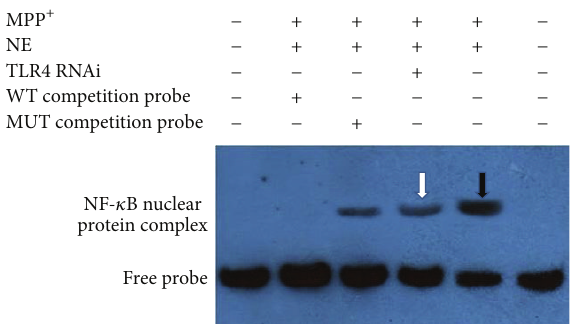
Figure 8: The effect of TLR4 RNA interference on NF- 𝜅 B activation in BV-2 cells exposed to MPP + for 12h (negative control group; WT cold probe group; MUT cold probe group; RNAi group; non-RNAi group; negative control group). Note that, in the group treated with TLR4 RNA interference, NF- 𝜅 B activation decreased compared to that of non-RNAi